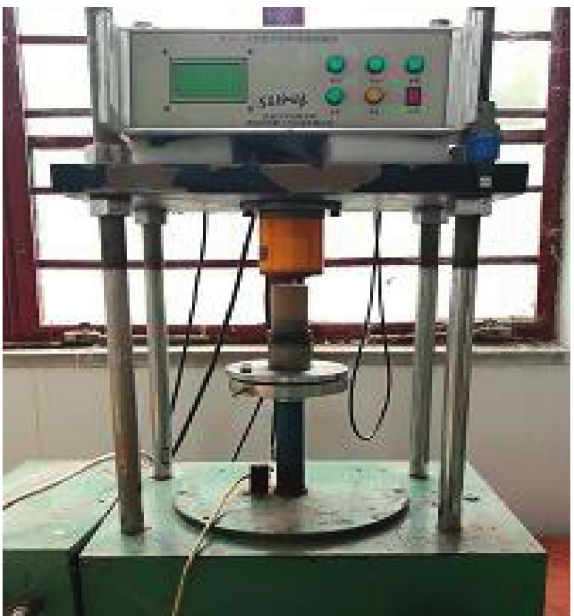
Figure 3: UCS test procedure.